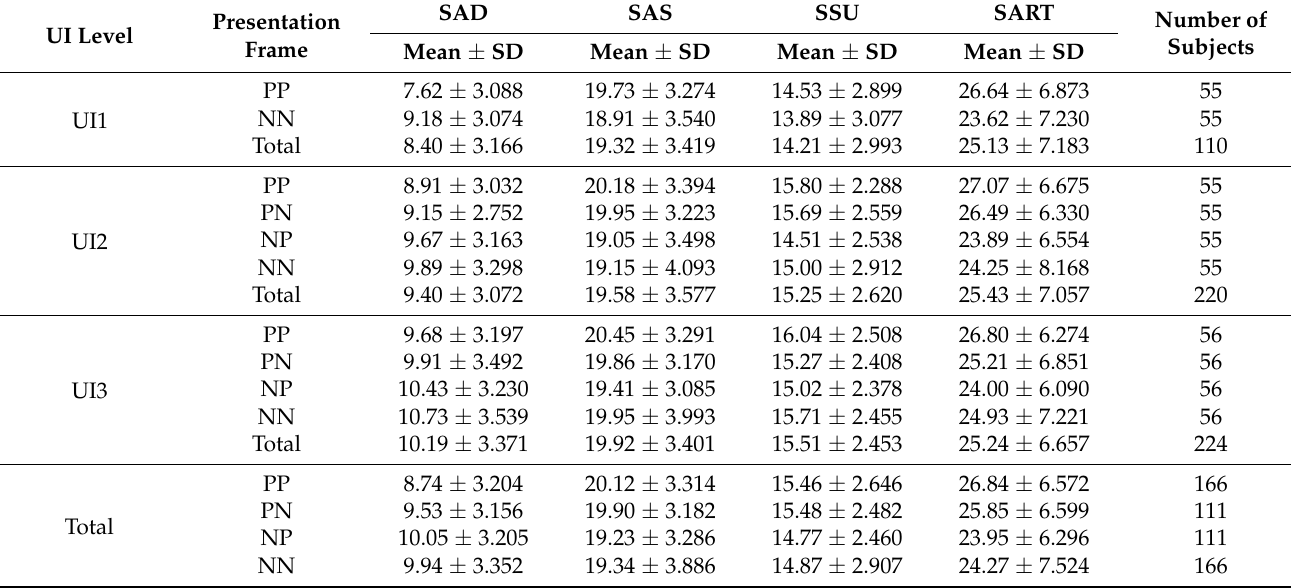
Table 5. The dimension and the total scores obtained by SART.